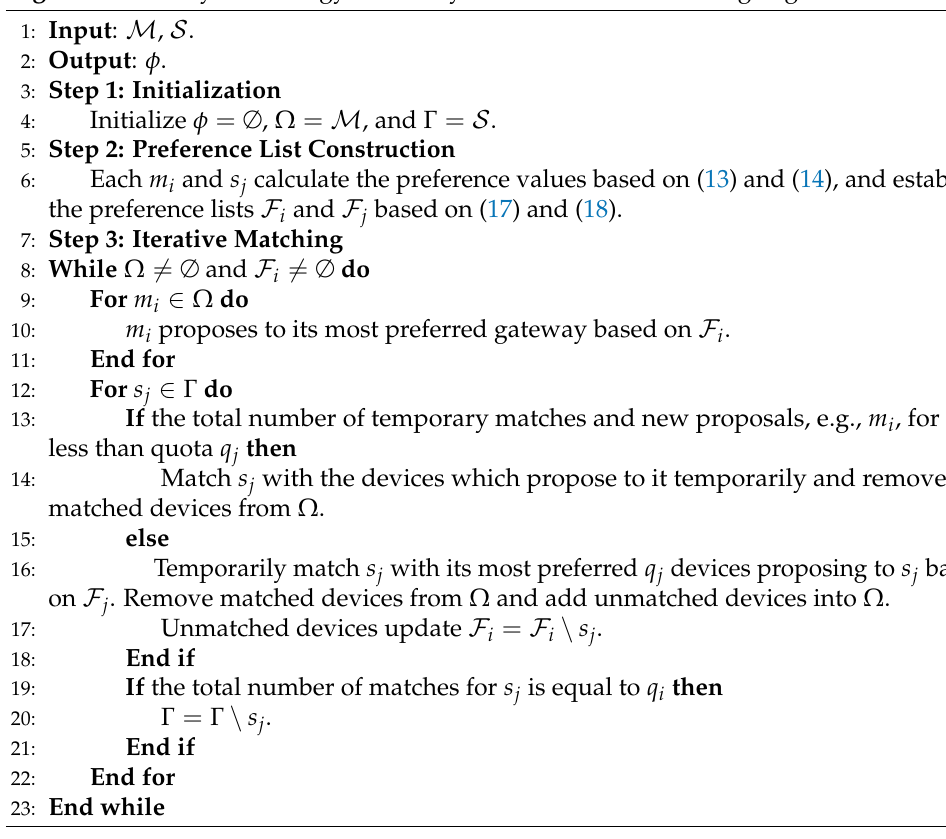
Algorithm 1 Delay and Energy-Efficiency-balanced Task Offloading